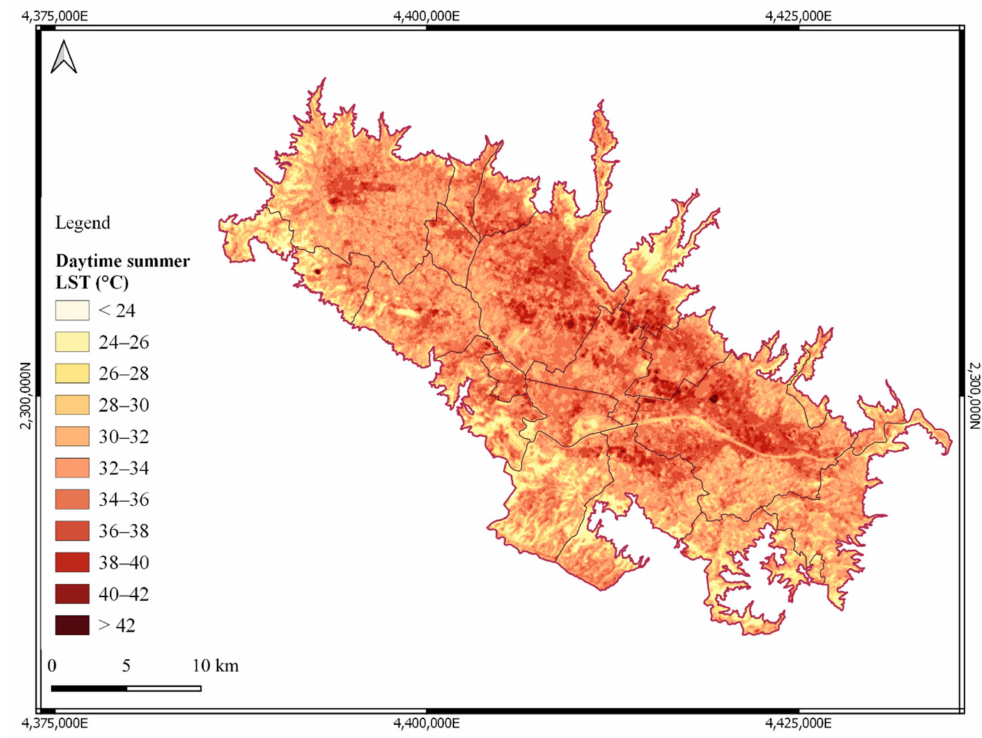
Figure 3. Daytime summer land surface temperature (LST) map (2015–2019).